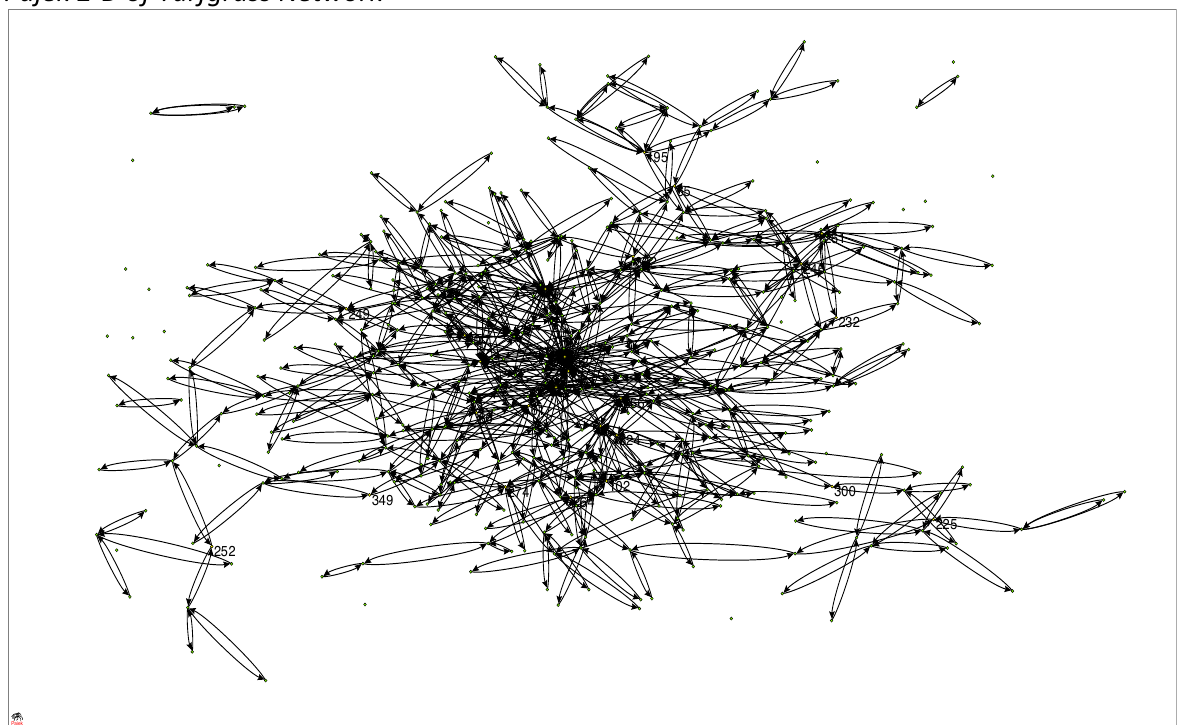
Figure 1 Pajek 2-D of Turfgrass